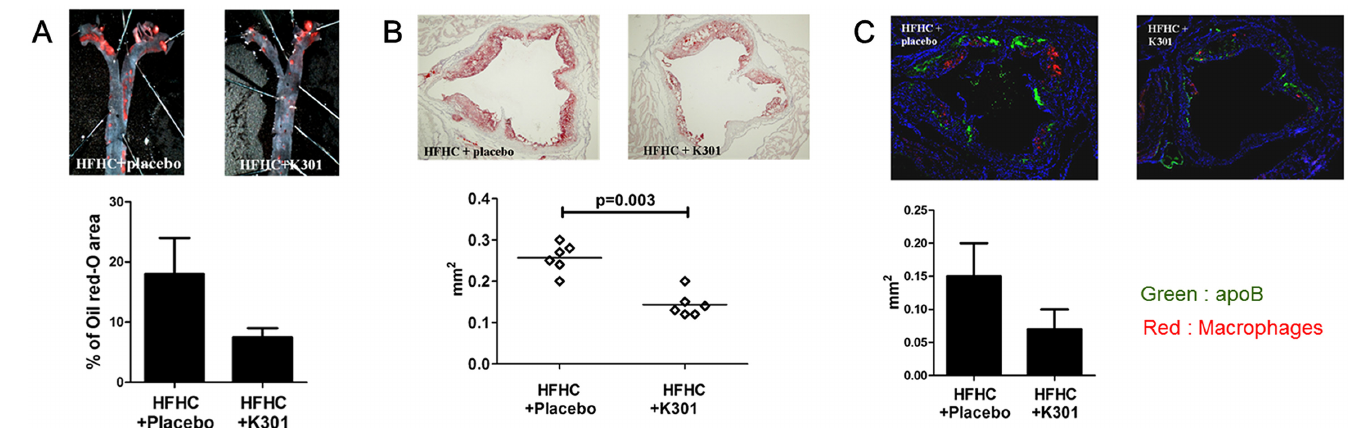
Fig 7. Administration of L . acidophilus K301 prevented atherosclerotic lesion development. ApoE -/- mice were treated with heat-killed L . acidophilus K301 and/or a high-fat high-cholesterol (HFHC) diet for 8 weeks. (A) Representative en face Oil Red-O stained aortas from ApoE -/- mice fed an HFHC diet and co-treated daily with 1×10 13 /kg heat-killed L . acidophilus K301 for 8 weeks is shown, and the percentage of Oil Red-O stained area was calculated (lower panel). (B) Oil Red-O stained areas of aortic sinus are shown with quantitation by computer-assisted morphometery (lower panel). All results are shown as mean ± S.D. (C) Accumulation of ApoB-100 and macrophages in HFHC-fed ApoE -/- mice and heat-killed L . acidophilus K301-infused ApoE -/- mice was examined by immunofluorescence analysis. ApoB and macrophages from the area inside the plaques in each group are displayed. In all color images, DAPI is shown in blue, and target proteins in green (ApoB-100) or red (macrophages). Data shown is representative of three independent experiments.